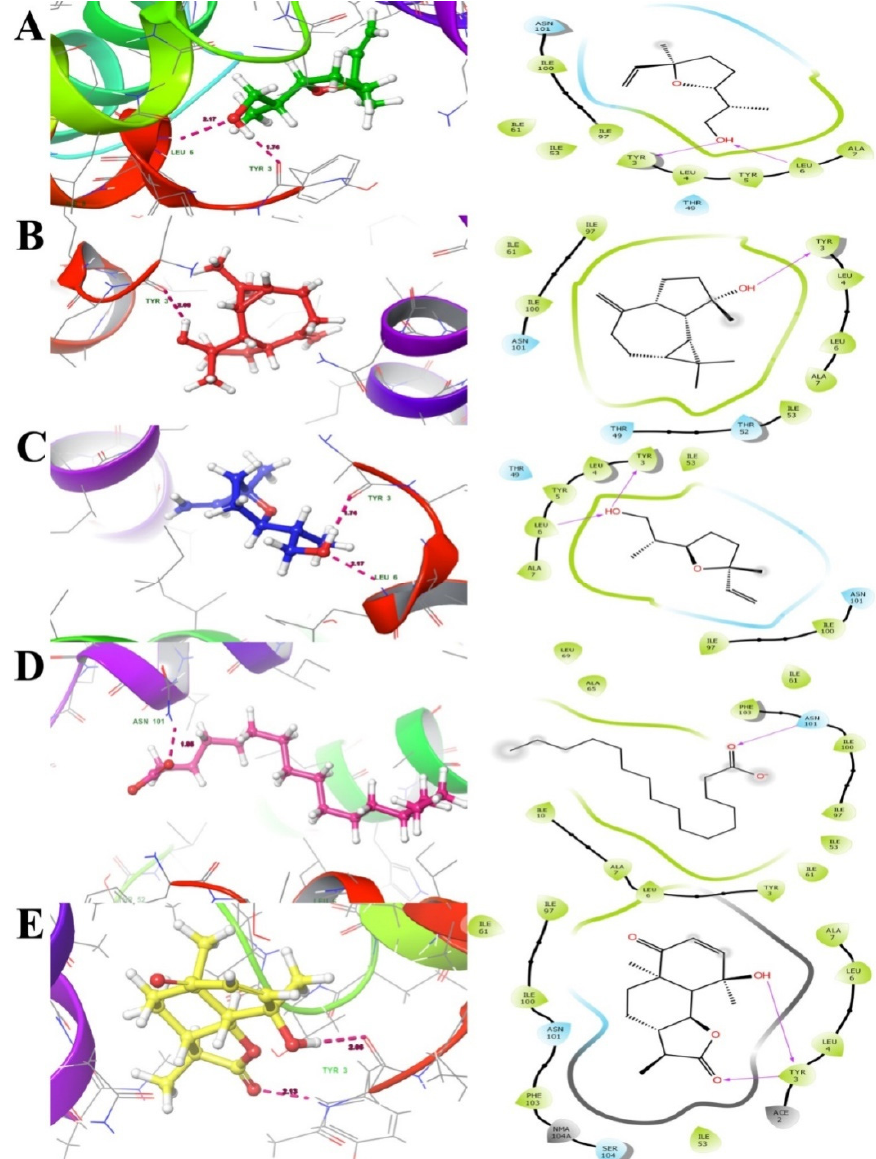
Figure 5. Docking interactions of ligands (( A ). 033081-34-4, ( B ). 006750-60-3, ( C ). 033081-36-6, ( D ). 000057-10-3and ( E ). 000148-21-7) with efflux protein ligand docking poses represented in threedimensions (Left) and twodimensions (Right). The ligands are shown as a ball and stick model and the dotted pink lines indicate hydrogen bond interactions and the residues.